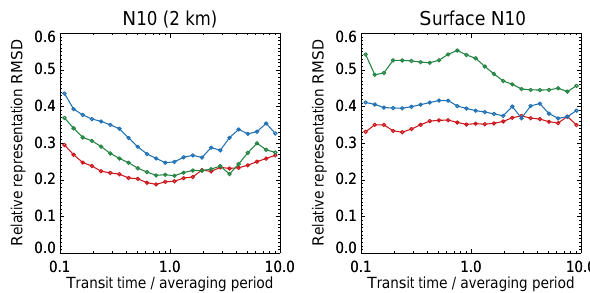
Figure 23. Relative representation RSMD for N10 measurements as a function of transit time over averaging period, for W-Europe (red), Oklahoma (blue) and Congo (green). Further explanation in Sect.